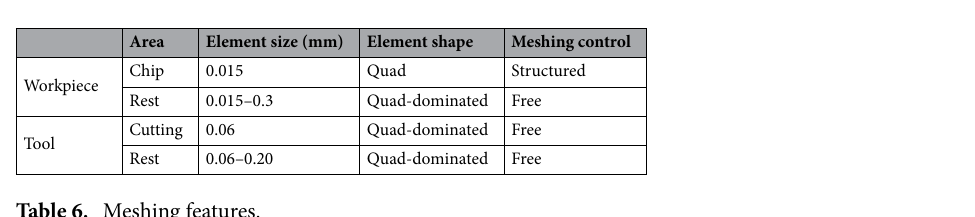
Table 6. Meshing